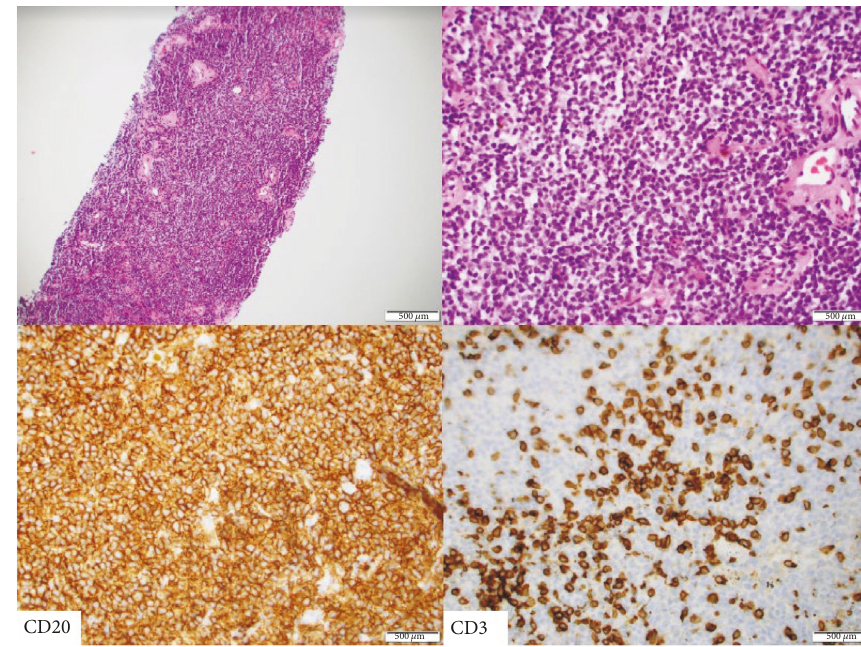
Figure 2: The two pathology pictures are low and high power of hematoxylin and eosin-stained slides showing proliferation of small lymphocytes, a few of them exhibiting monocytoid morphology. The bottom left is CD20 immunostaining highlighting the neoplastic B cells. Bottom right is CD3 immunostaining highlighting the background benign small T cells consistent with diagnosis of marginal zone